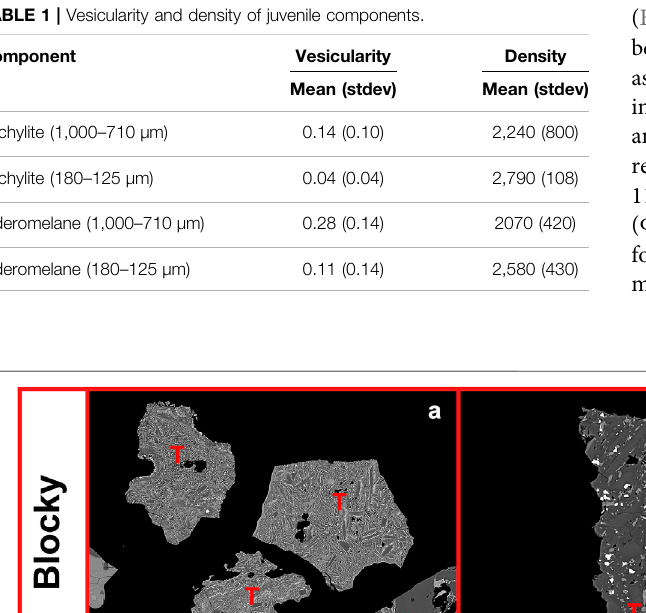
Frontiers in Earth Science |